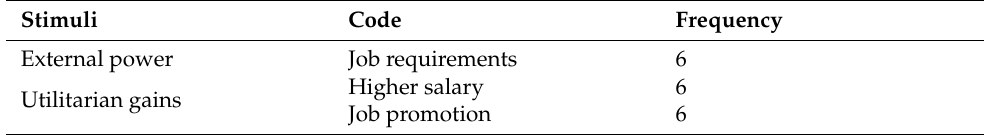
Table 4. Stimuli of non-English majors in English